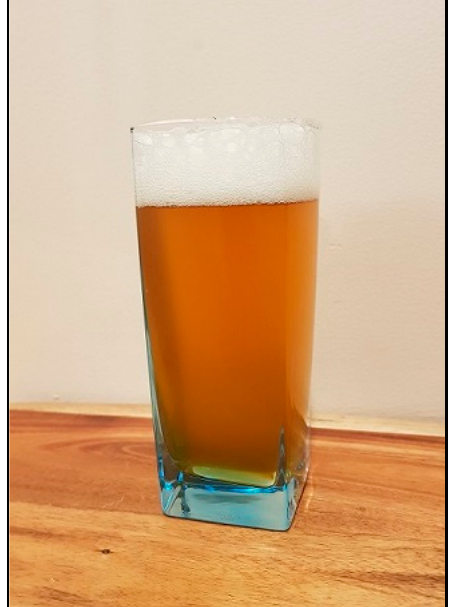
Figure 1. The photograph of the beer presented to participants.